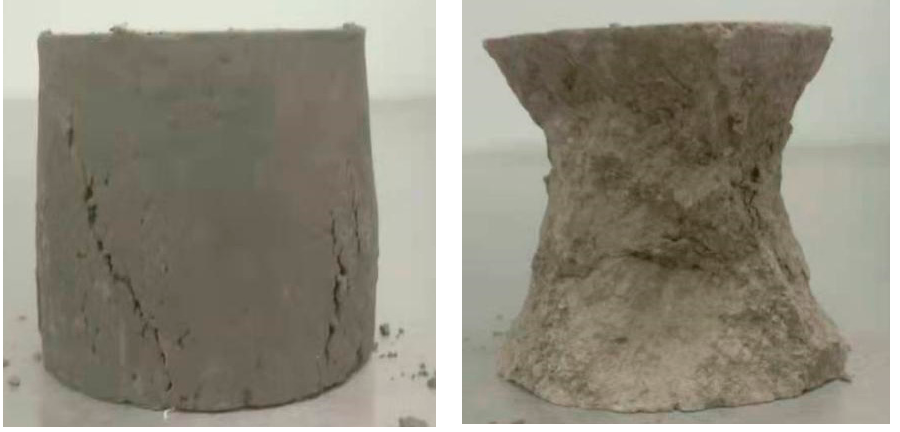
Figure 7. Unconfined compressive strength test results.